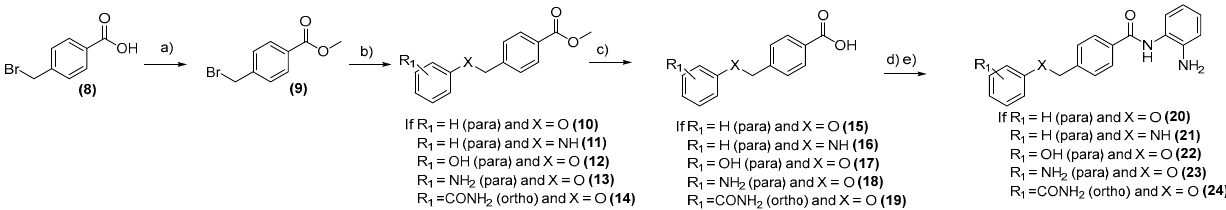
Figure 9. Synthesis of compounds ( 20 )–( 24 ).